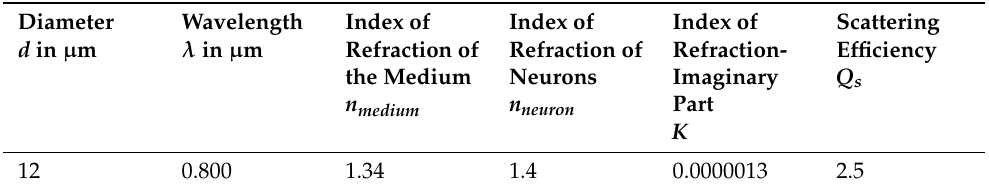
Table 2. The data used to calculate the scattering efficiency ( Q s ) for the gray matter of the cerebral cortex of the human brain tissue